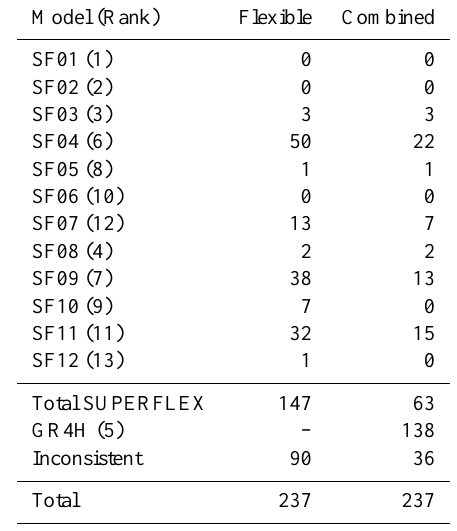
Table 4. Number of times each structure is selected as “best- performing” for the flexible approach alone (column labelled “Flex- ible”) and when GR4H is considered as one of thirteen structures (column labelled